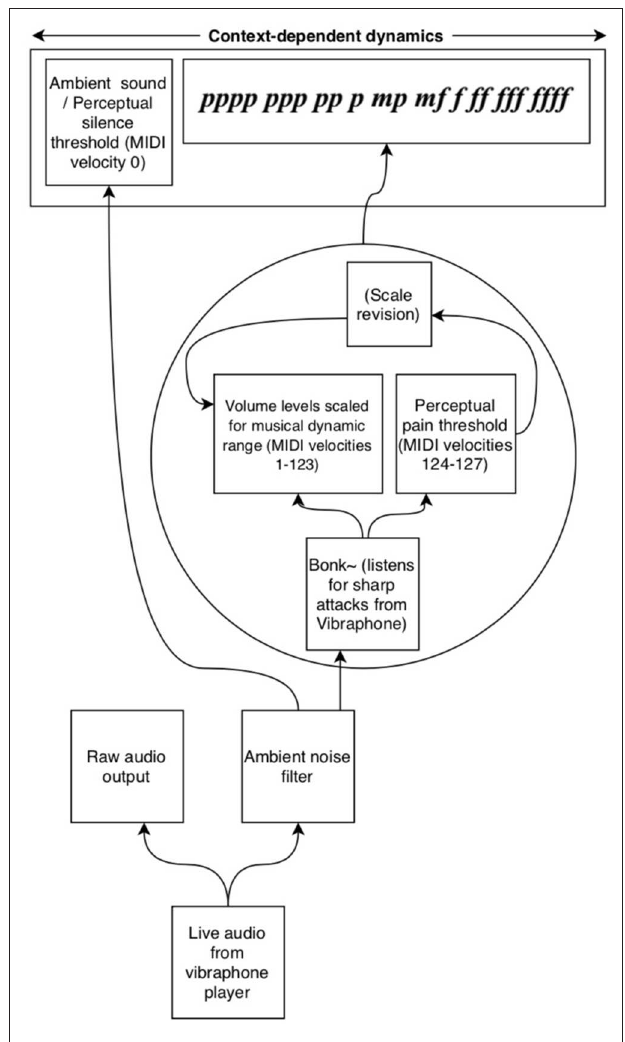
FIGURE 1 | A schematic of Avatar’s process for establishing context-dependent dynamics by listening to incoming